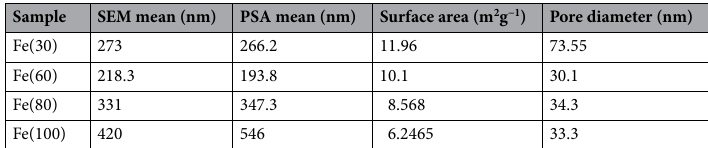
SEM). Surface area of particles measured by BET shows a gradual decrease with increasing MW time due to the graphitization and combination of high surface area ACB particles with sodium iron phosphate particles (Vul- can XC 72 R has a typical surface area of 235 m 2 g −136 ). The measured surface areas and pore diameters are listed in Table 3. The BET and BJH plots are provided with supporting information Figures S2 and S3. The surface area for Fe(60) is 10.1 m 2 g −1 .The previously reported surface areas for NaFePO 4 are range from 3.5 for micro particles to 120 m 2 g −1 for 15 nm hollow nanoparticles 16,37–39 . TEM images for the Fe(60) sample show that the graphitized carbon is well distributed on the particle’s surface, but with unequal thickness. The large particles observed in TEM images are composed of small irregular spherical nano-crystallites of about 10–15 nm with an intergranular amorphous matrix as shown in Fig. 4e,f. Selected area electron diffraction (SAED) is shown in the inset of Fig. 4f confirms the presence of a large amount of amorphous phases indicated by continuous circles and a low amount of crystalline phase indicated by plane spots 39 . Figure 4f,g represent the fast furrier transform (FFT) image and Inverse FFT (IFFT) profile for the selected area, giving d spacing of 1.77 Å for Fe(60) sample along (240) plan. They also indicate the presence of many lattice defects and different growth directions due to the fast microwave heating. Figure 4h,i represent the elemental mapping for the Fe(60) sample, showing the uniform distribution of Na, Fe, P, and O in the selected particles. Carbon coating was also successful and nearly homogenous along the particle’s surface. This homogeneity may be due to the very low size of activated carbon used and the presence of glucose as an additional carbon source. Electrochemical characterization. Sodium ion battery cell. Figure 5a shows the first discharge profiles of samples at 0.2 C rate. The discharge capacities at different C-rates are listed in Table 4. The best discharge capacity obtained is 108.4 mA h g −1 for Fe(60) sample Vs Na/Na + , which is characterized by the presence of the highest amount of crystalline maricite phase (according to XRD patterns) and the smallest particle size (according to PSA). The order of capacity was Fe(60) > Fe(80) > Fe(100) > Fe(30). For the sample Fe(30), the low capacity may refers to the presence of a large amount of unreacted inactive raw materials. The decrease in capacity with increasing microwave time above 60 s may refer to the decrease in particle size and to the increase in surface area (Table 3). The first charge cycle for all samples exhibits a relatively elevated voltages due to energy consumed during extraction of Na that occupies the corners of the orthorhombic bipyramid in the maricite structure 40 . As shown in the inset of Fig. 5a, the second charge processes have lower voltages compared to the first. This is because the intercalated Na ions occupy the framework channels in maricite NaFePO 4 . After the first charge–discharge cycle, maricite NaFePO 4 is converted to amorphous phase, so that Na + ions become easier to extract 12,13 . Figure 5d shows the difference in XRD pattern before and after cycling, indicating the conversion of the maricite into an amorphous phase. Nyquist plots of samples are presented in Fig. 5c. The R CT values indicate that the sodium ion diffusivity inside the cathode matrix was in the order of Fe(60) > Fe(80) > Fe(100) > Fe(30). order, indicating that the enhancement in electronic conductivity of samples is the key factor for improving rate capability. Figure 5,b shows the charge–discharge curves at a different rates for sample Fe(60), the corresponding